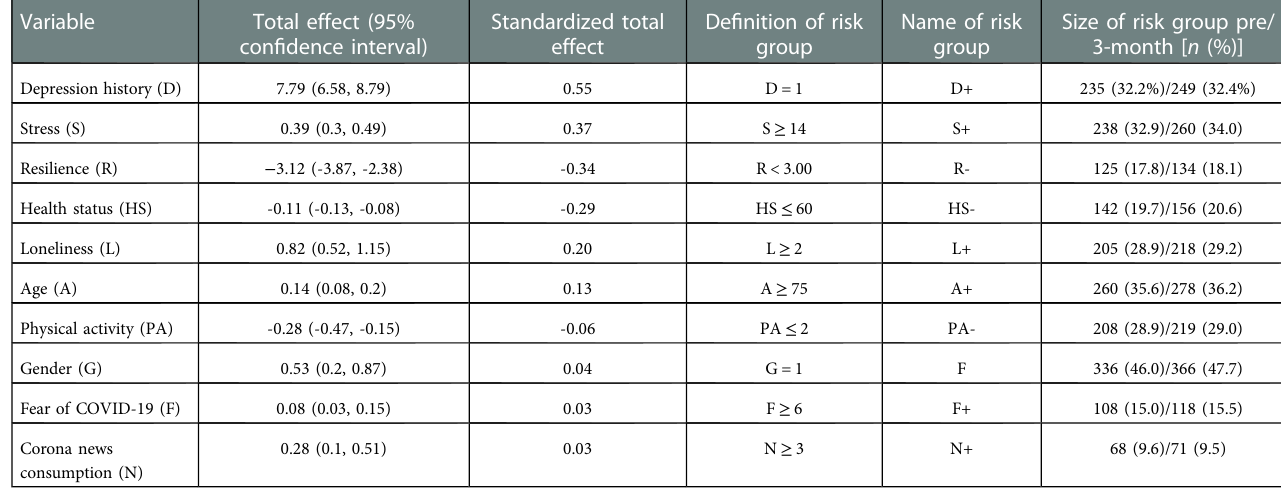
TABLE 2 Total effects of putative risk factors for increased severity of depression in the path model at 3-month peri-pandemic, and absolute and relative frequencies of individuals with and without these risk factors pre-pandemic and at 3-month peri-pandemic. Risk factors were measured at 3-month peri-